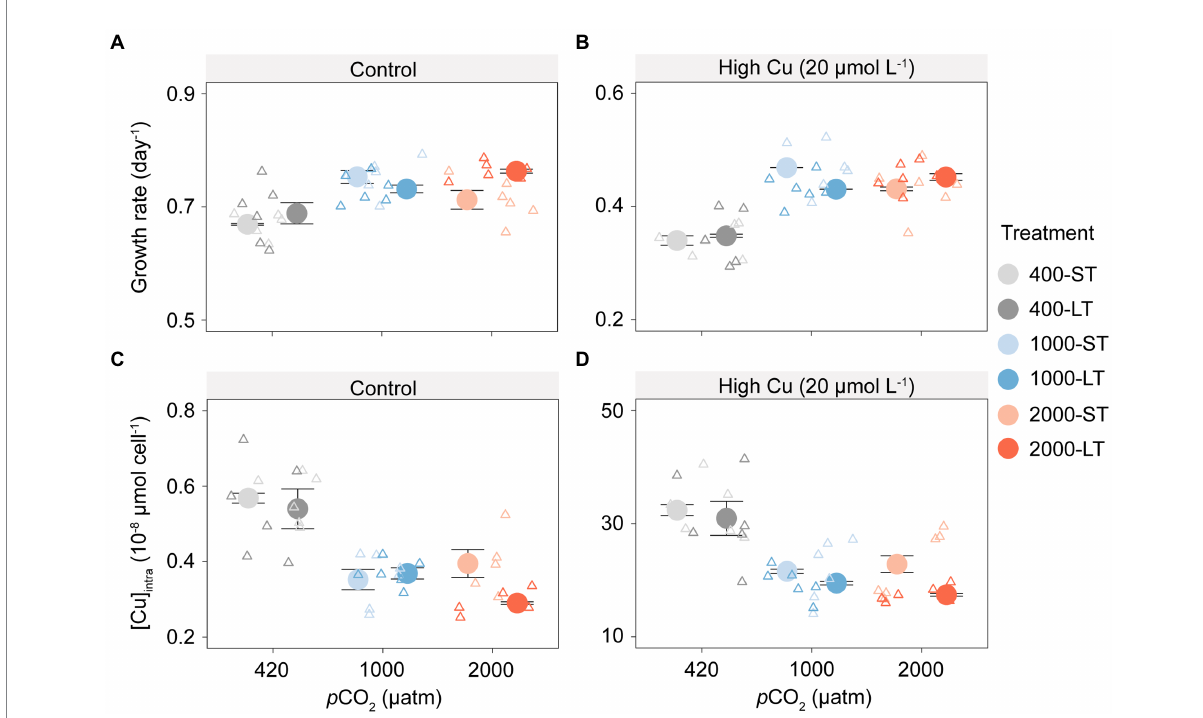
FIGURE 3 Growth rates and intracellular copper concentration of T. pseudonana in outdoor culture experiments after short-term (ST) and long-term (LT) acclimation under different p CO 2 with or without added copper. Changes in growth rate to increasing p CO 2 without (A) or with (B) copper exposure; Shift in intracellular copper concentration ([Cu] intra ) to increasing p CO 2 without (C) or with (D) copper exposure. The values represent the means and error bars represent standard deviations of triplicate